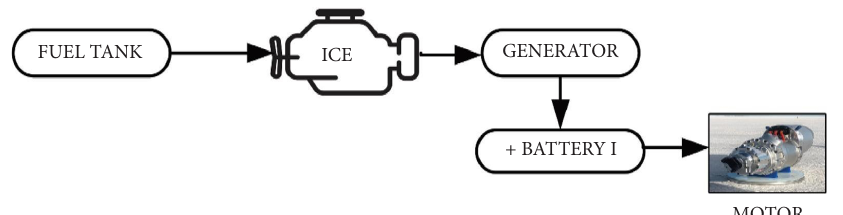
Figure 4: A simple block diagram of ER-ICE